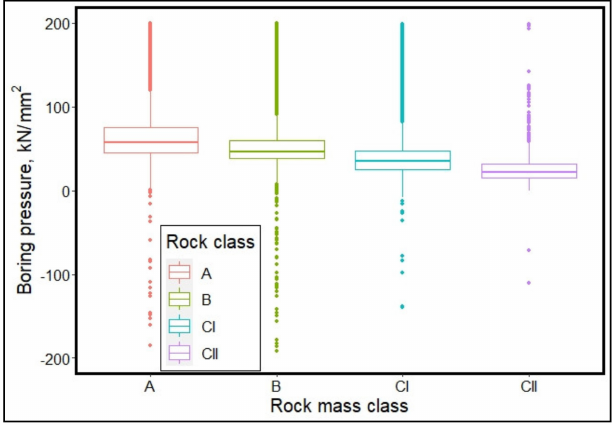
Figure 6. Distribution of boring pressure in different rock mass